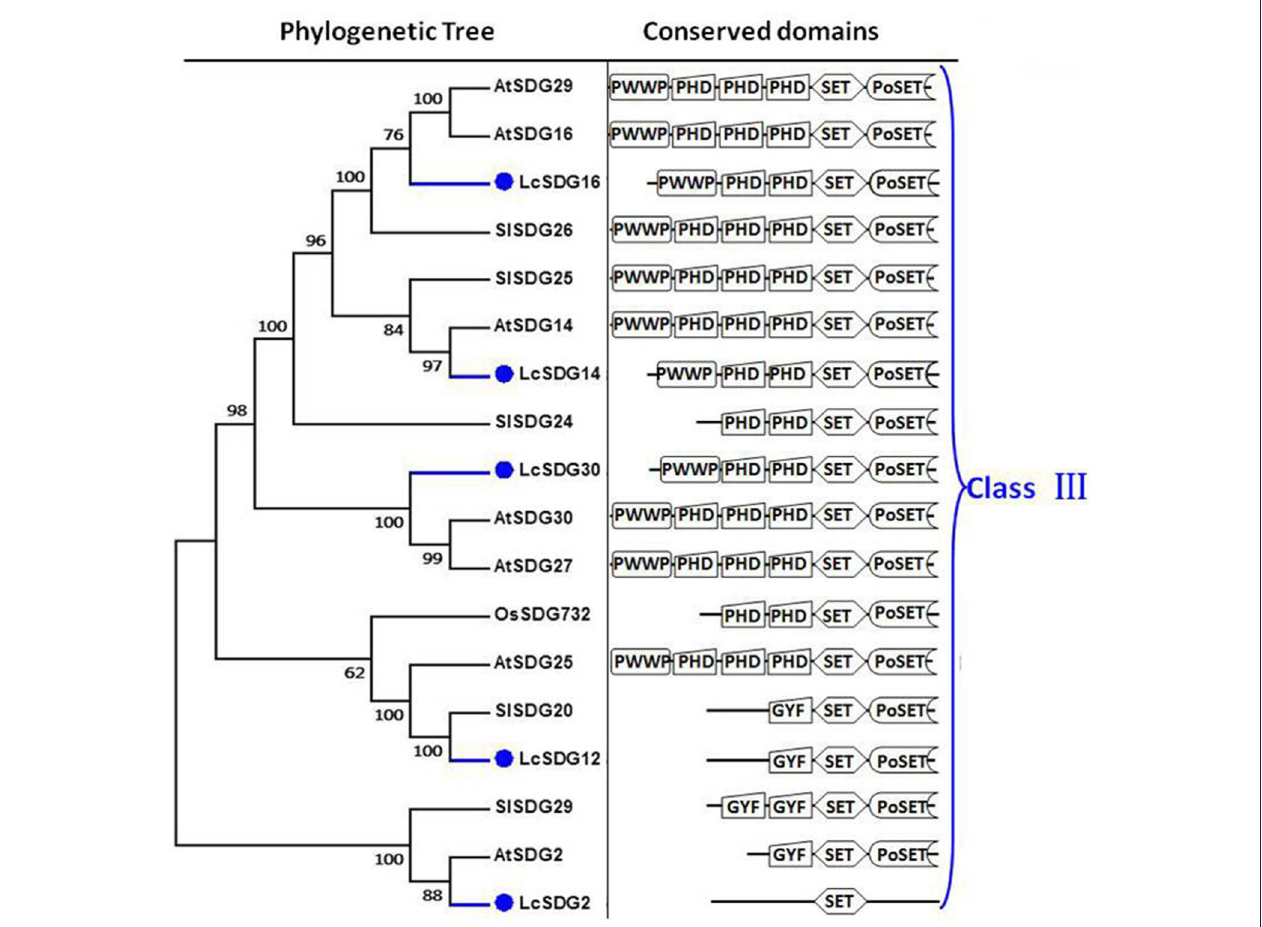
FIGURE 4 | Maximum likelihood phylogenetic trees and schematic diagrams for domain composition of class III HMT proteins predicted from Litchi chinensis (Lc), Arabidopsis thaliana (At), Oryza sativa (Os), and Solanum lycopersicon (Sl). N-terminal PWWP (PF00855), two PHD, SET, and Post-SET are conserved domains of Class III. Some Class III proteins have N-terminal GYF (PF02213) but lack the PWWP (PF00855), two PHD domains. The phylogenetic tree was constructed based on the amino acids sequences with 1,000 bootstrapping replicates.